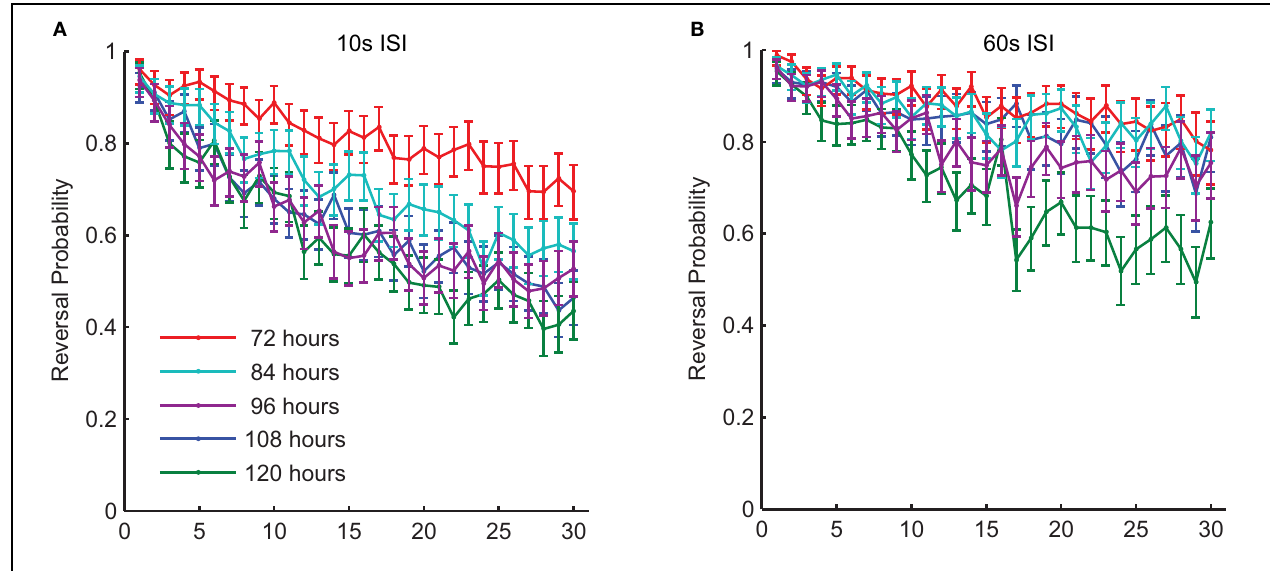
FIGURE 6 | There were changes in habituation of response probability throughout middle-age in wild-type worms. This graph shows response probability habituation for 72-, 84-, 96-, 108-, and 120-h-old (all reproductive